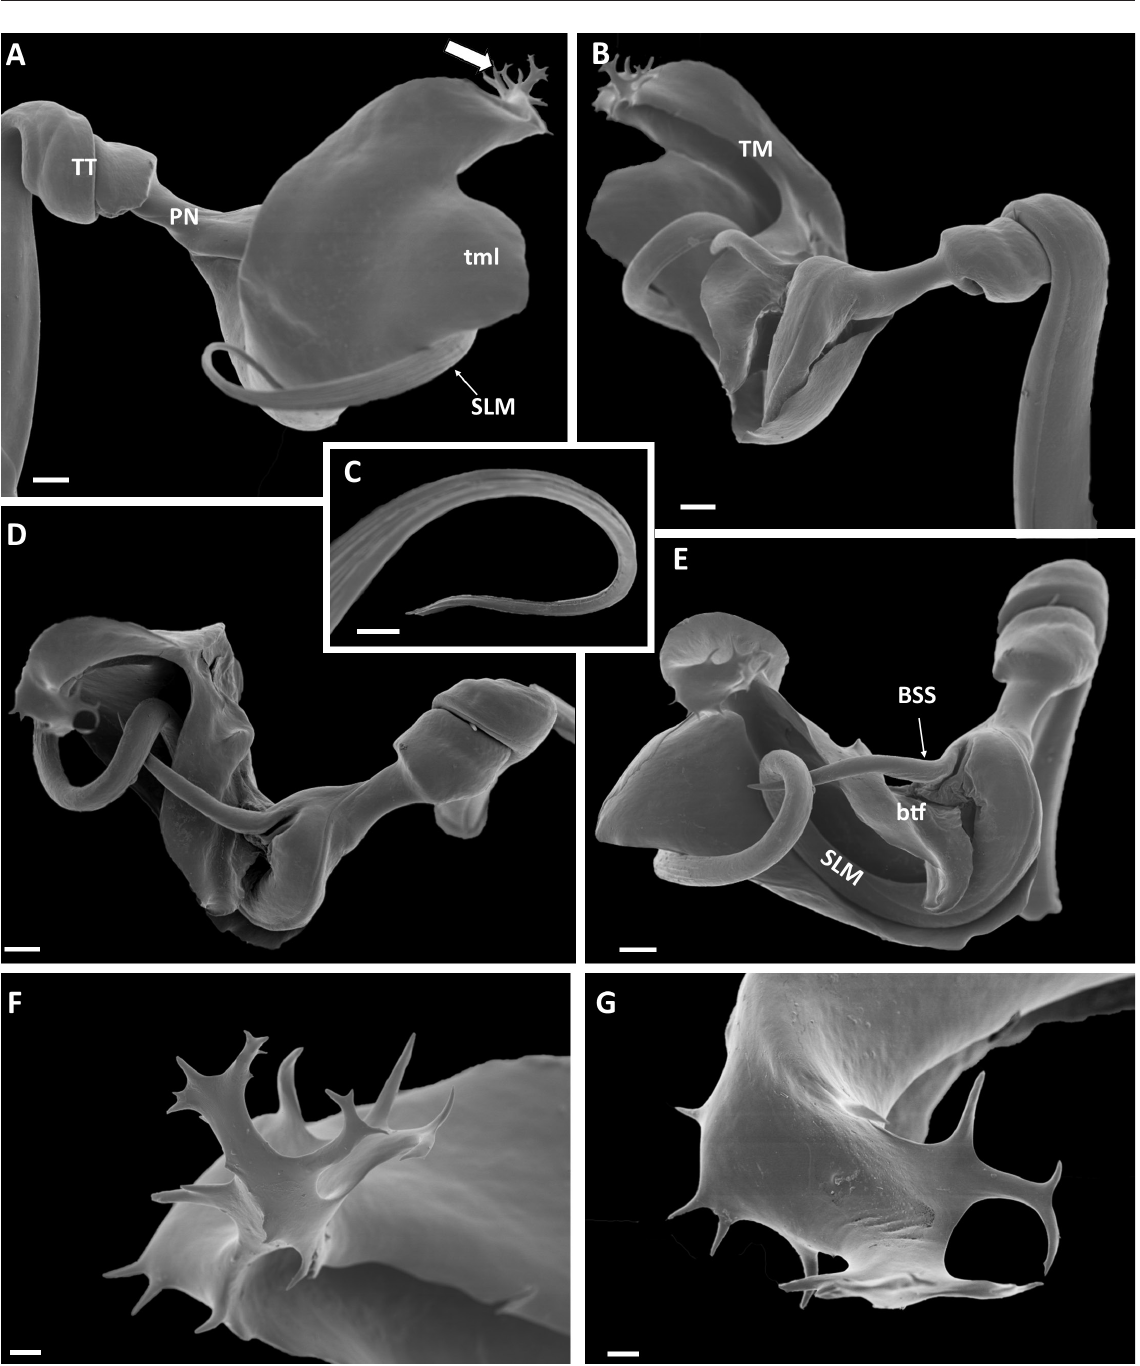
Fig. 61. Uncodrama coronata gen. et sp. nov., holotype, ♂ (NHMD 621765), left gonopod telopodite. A . Anterior view. B . Posterior view. C . Tip of solenomere. D . Ventral view. E . Submesal view. F–G . Two views of terminal anterlike structure on telomere. Abbreviations: BSS = basal solenomeral spine; btf = basal telomeral flange; PN = post-torsal narrowing; SLM = solenomere; tml = telomeral lobe; TT = torsotope . Scale bars: A–B, D–E = 0.1 mm; C = 0.05 mm; F–G = 0.02